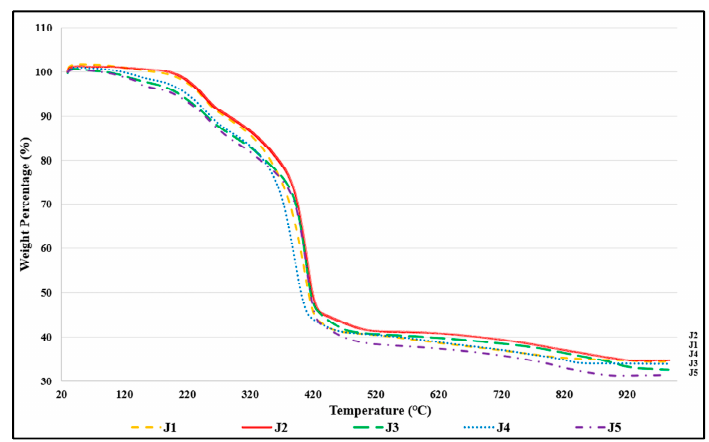
Figure 10. TGA curves of each coating sample.